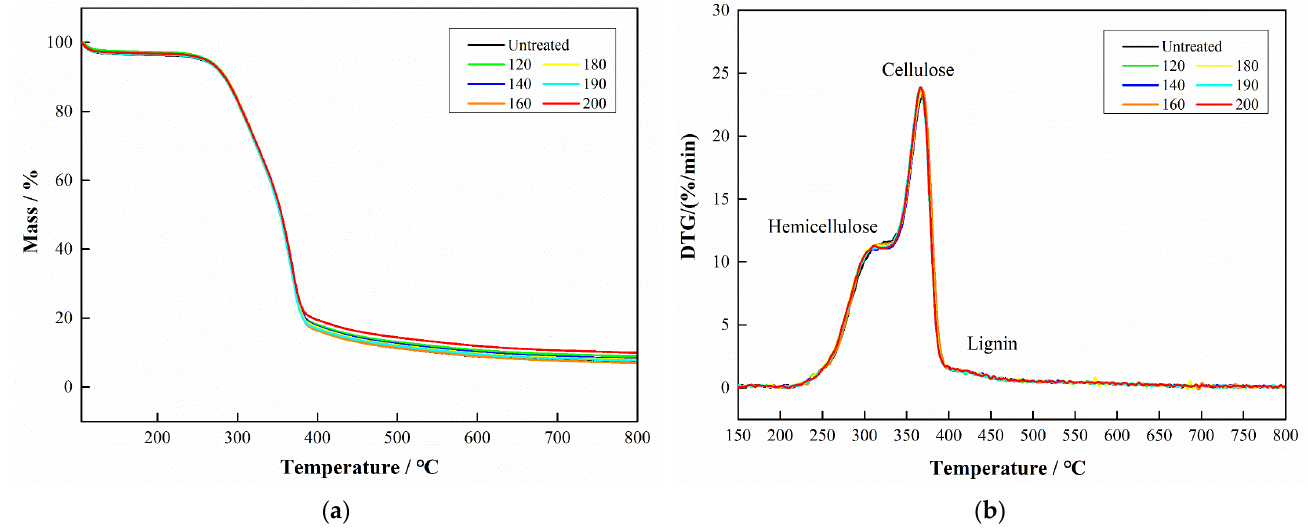
Figure 8. TG curves ( a ) and DTG ( b ) of beech in the heat treatment temperature 120–200 ◦ C range.